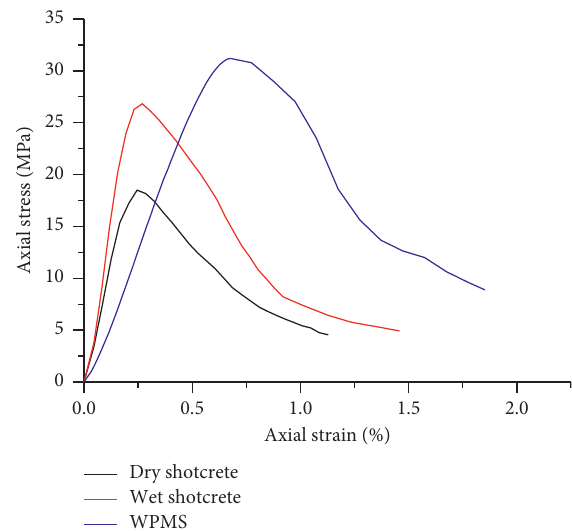
Figure 3: Stress-strain relationships for three different shotcrete mixes subject to uniaxial